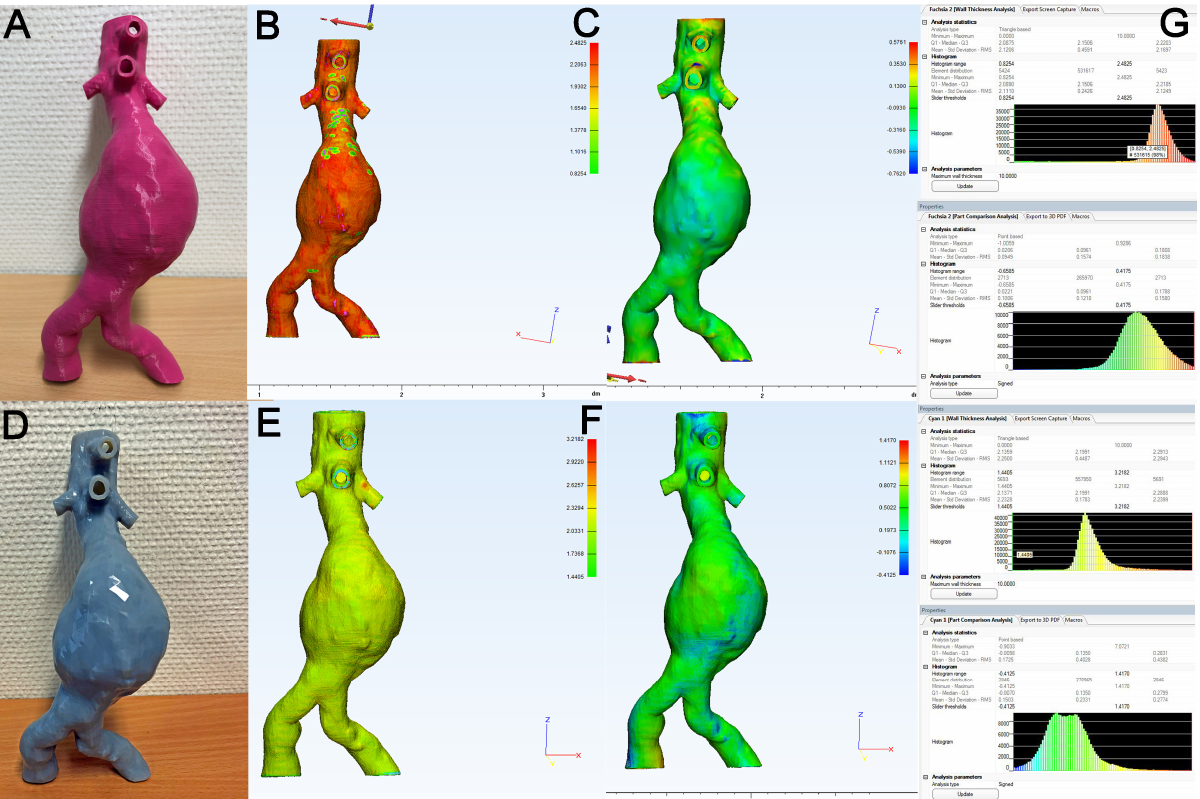
Figure 6. Representative examination of 3D model of infrarenal aortic aneurysm. ( A ): 3D model generated in fused deposition modeling (FDM) printing (rigid polylactic acid (PLA)). ( B ): Color map of WTA. ( C ): Color map of part comparison analysis (PCA). ( D ): 3D model generated in PolyJet printing (flexible polymer, Stratasys Tango ® gray, Rehovot, Israel). ( E ): Color map of WTA. ( F ): Color map of PCA. ( G ): Histogram results of WTA (lower middle panel) and PCA (lower